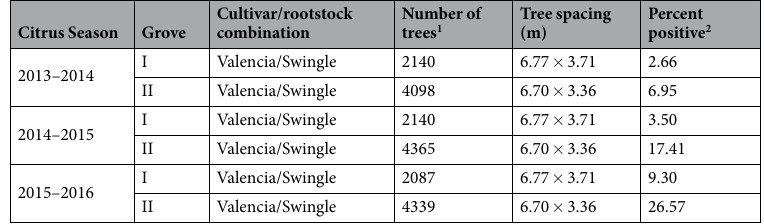
Table 4. Characteristics of Valencia orange groves surveyed in Florida for citrus black spot, caused by Phyllosticta citricarpa . 1 Number of trees, this includes fruit bearing trees and resets that have not reached the fruit bearing stage. From year to year the number of trees may change due to tree removal and planting of resets. 2 Percent positive reflects the number of trees with CBS positive fruit as a proportion of all trees in the planting including non-bearing